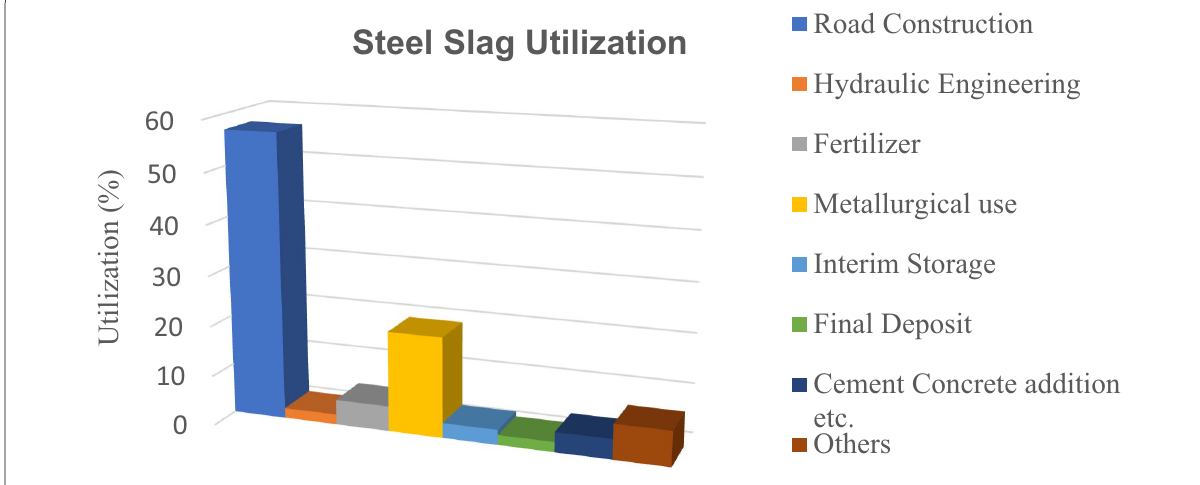
Fig. 1 Steel slag utilization in Europe for 2021 (Association, et al.,